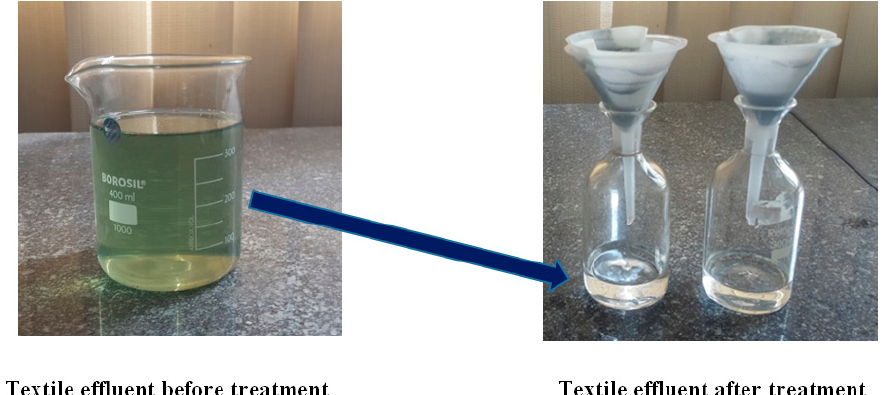
Figure 15. The images of the textile waste effluent before and after treatment.